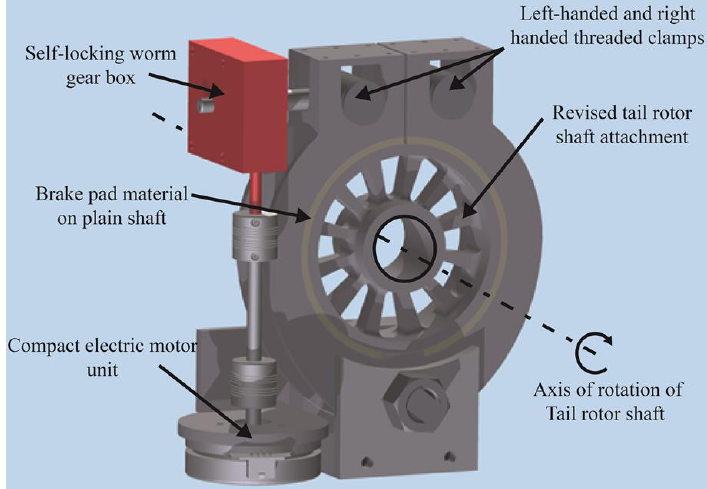
Figure 4. Winning concept (concept 1)—Worm gear driven threaded radial clamp with plain shaft frictional engagement.